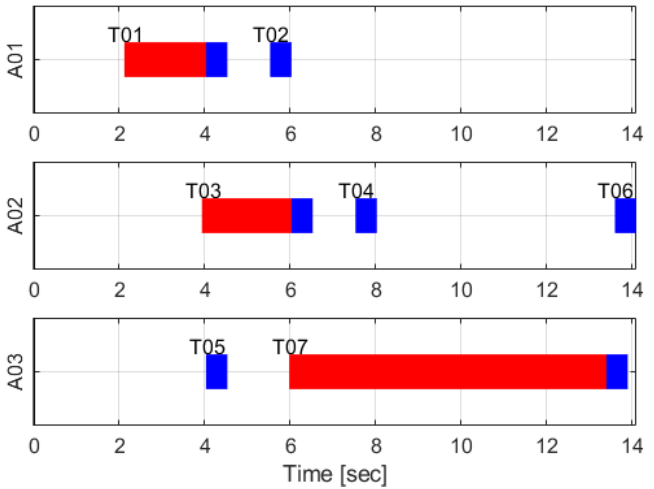
Figure 12. Timetable result of TACTAR for a complicated case applying an accumulated distance cost scheme.